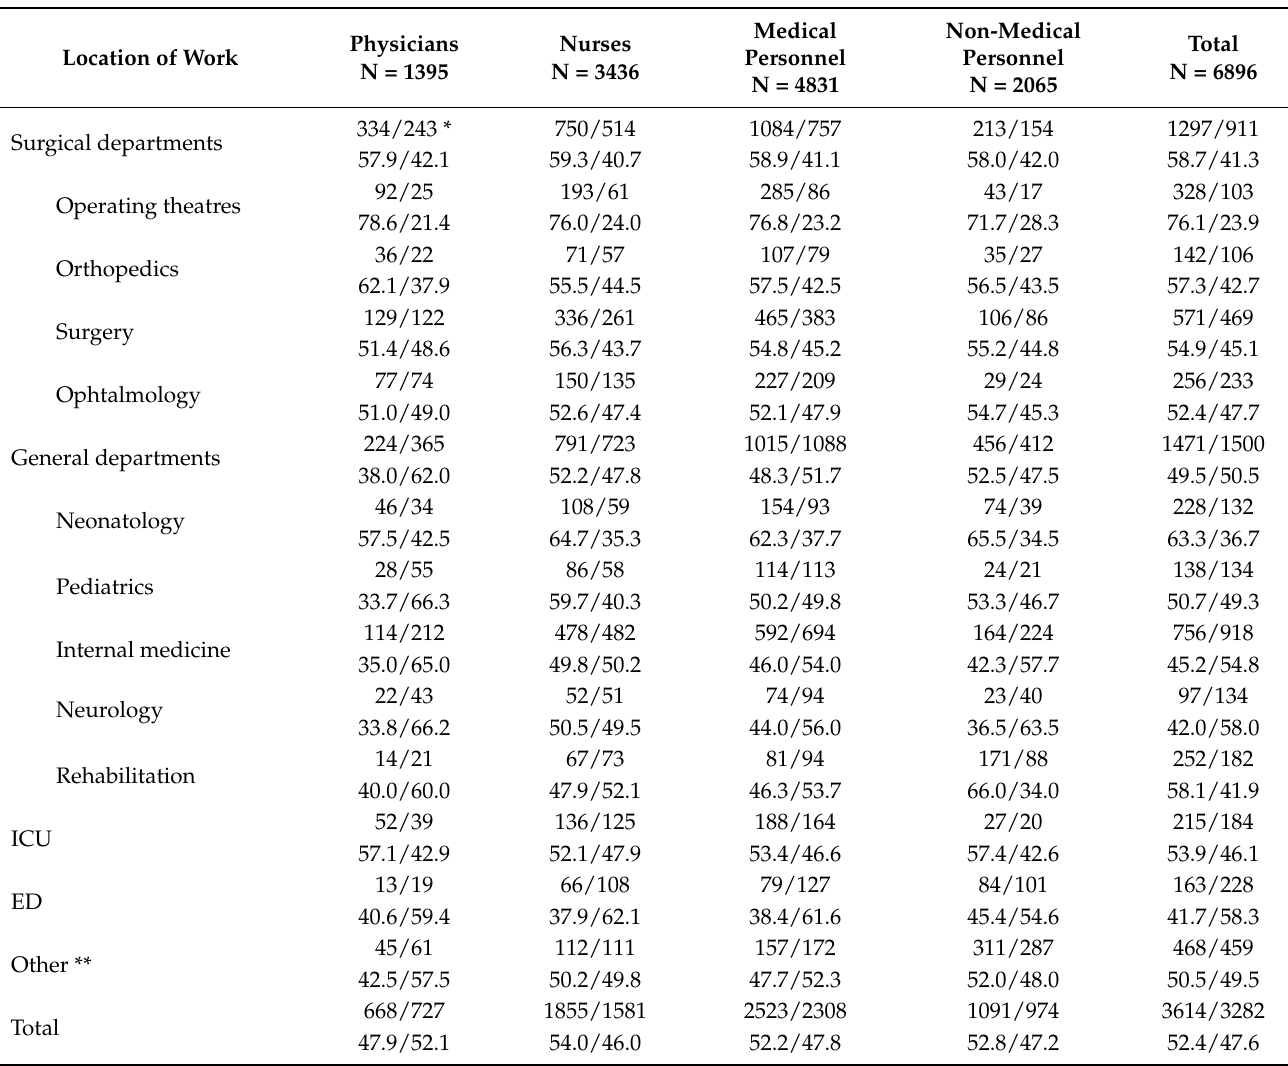
Table 2. Assessment of compliance with the BBE principle among hospital